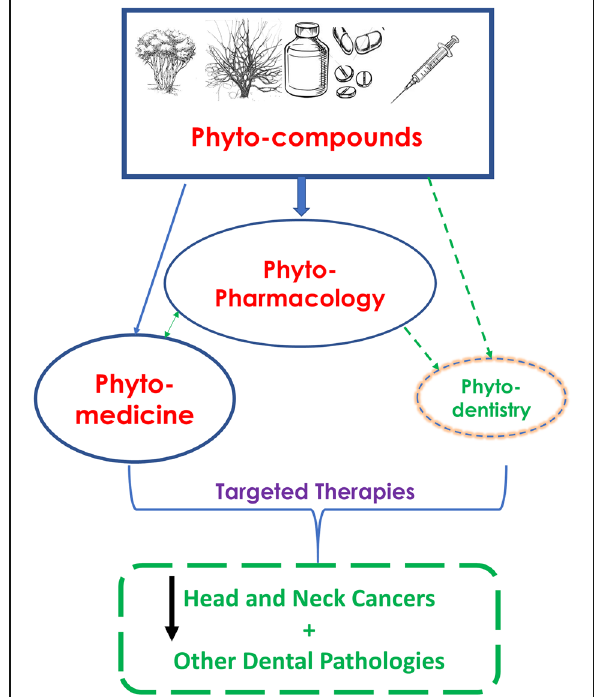
Fig. 1 Overview of potential impact (green highlight and broken lines) of phyto-dentistry on head and neck